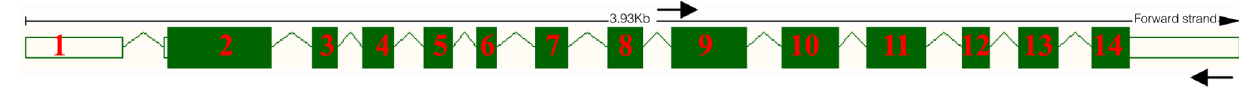
Figure 1. Gene structure of waxy gene in maize ( http://www.maizesequence.org/Zea_mays/GRMZM2G024993_T01 ). Boxes represent exons. Lines between exons represent introns. The region between the two arrows is the fragment used in this